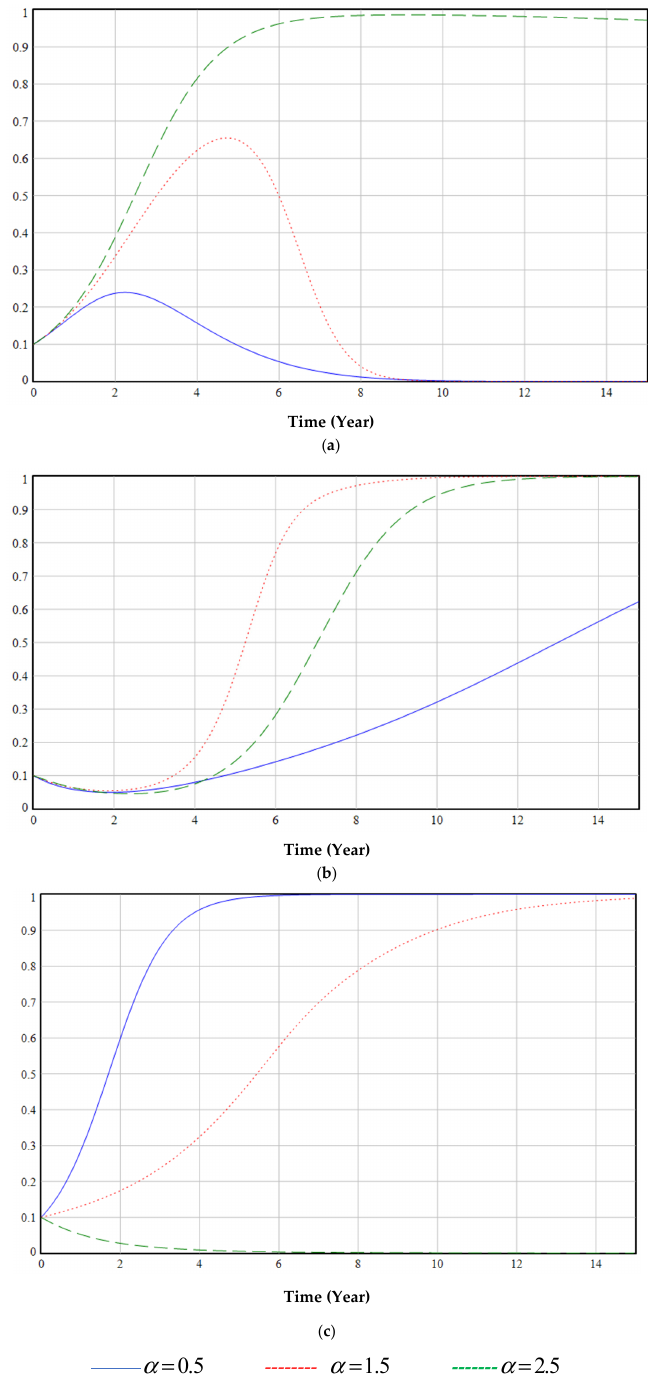
α Figure 11. The effect of on decisions of government ( a ), enterprises ( b ), and medical institutions Figure 11. The effect of α on decisions of government ( a ), enterprises ( b ), and medical institutions ( c ( c ).